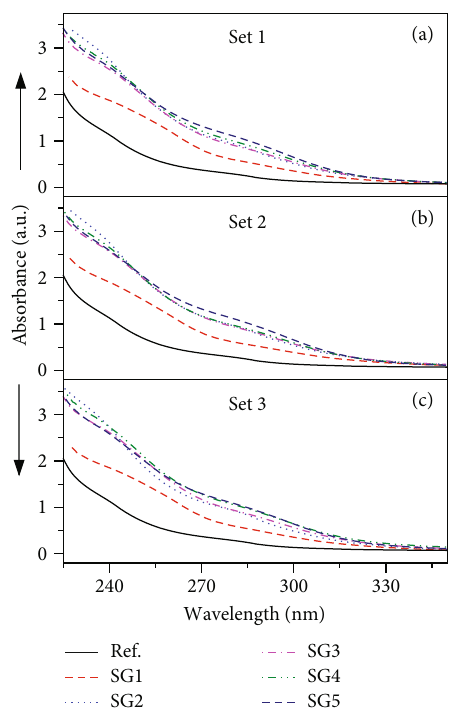
Figure 3: Absorption spectra (a) for di ff erent gamma dose irradiated, (b) for postalpha irradiation with di ff erent gamma dose, and (c) for prealpha irradiation with di ff erent gamma dose of PM-533 SSNTDs.